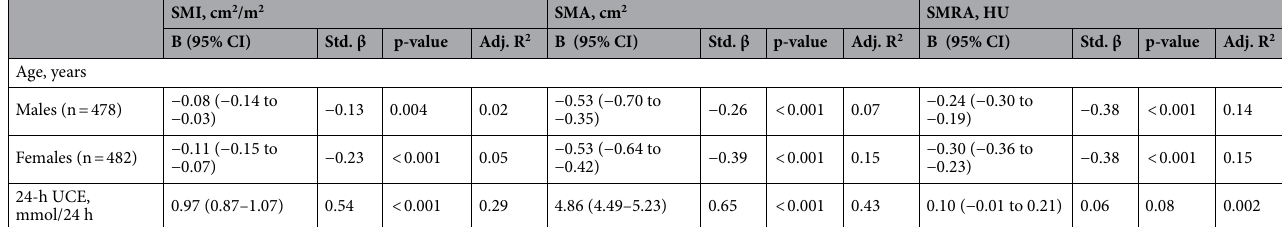
Table 2. Univariable linear regression analyses of age and 24-UCE with skeletal muscle parameters. Univariable linear regression analyses of age with skeletal muscle parameters were performed for male and